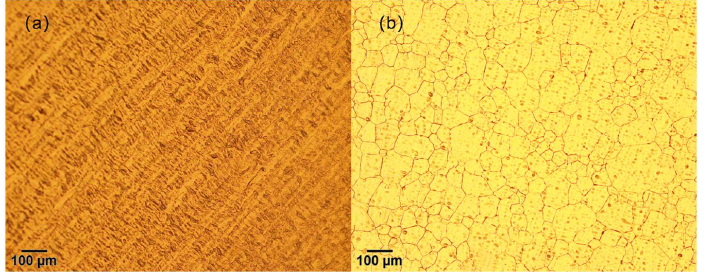
Figure 1. Optical microscope images of two types of copper foil ( a ) without graphene and ( b ) with graphene on the surface, respectively.